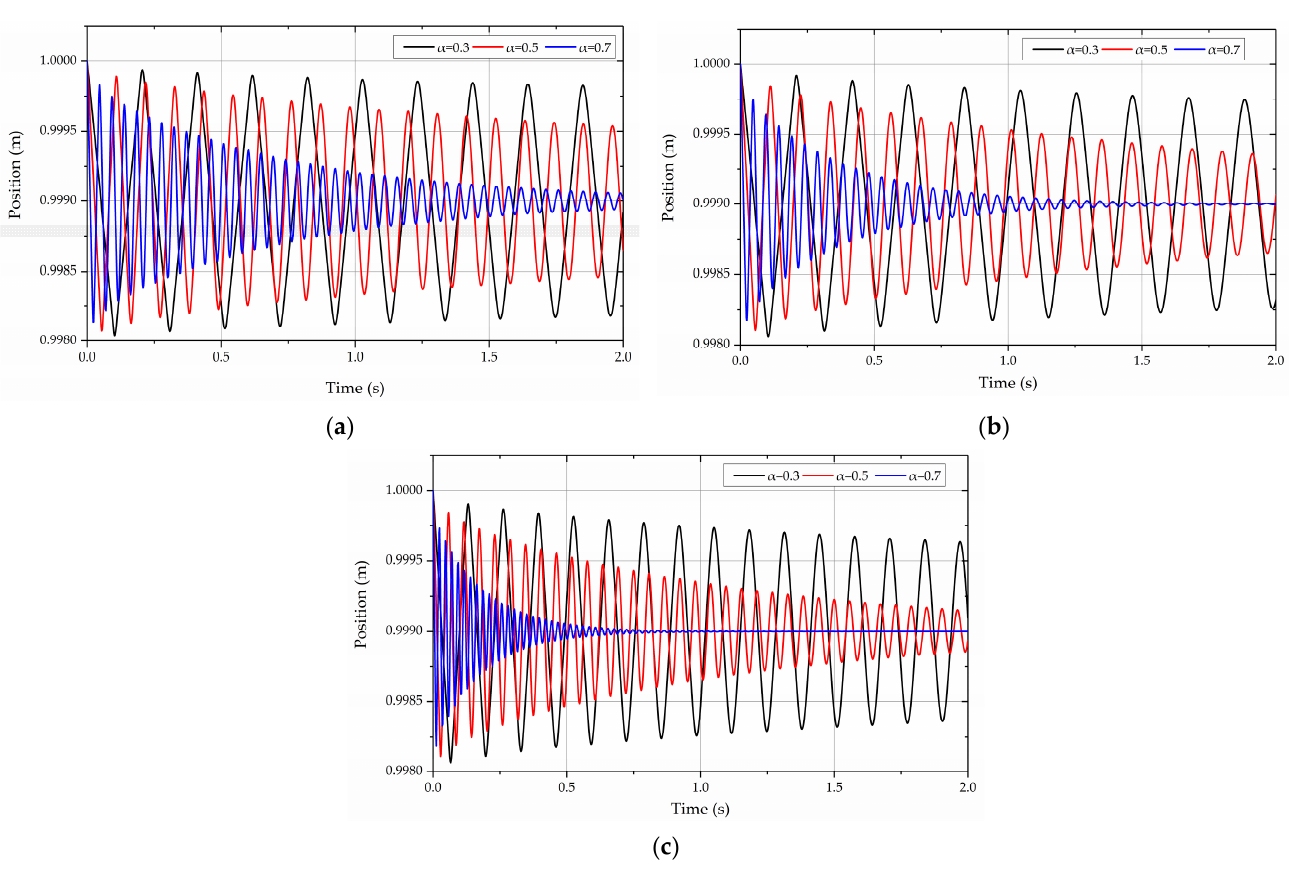
Figure 4. x-component of the free tip position at different derivative orders. ( a ) τ = 0.1, N t = 10; ( b ) τ = 0.1, N t = 40; ( c ) τ = 0.4, N t = 10.